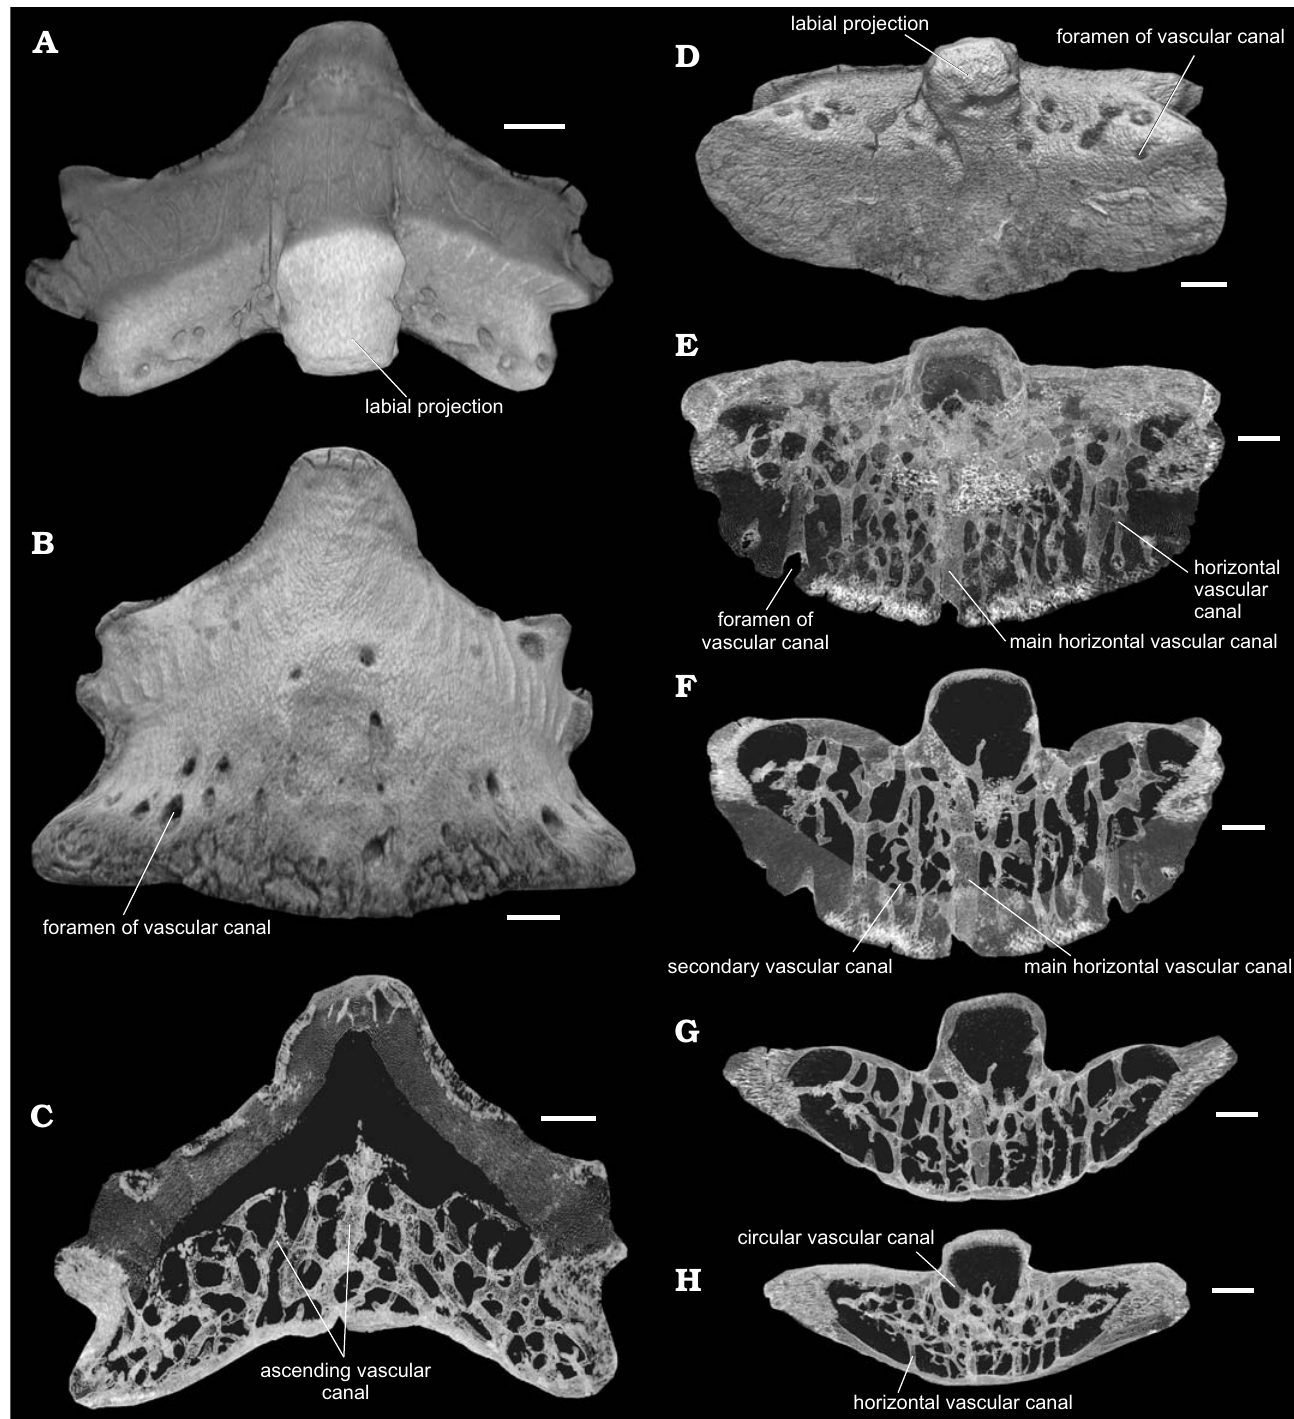
Fig. 5. Tooth (PM SPU 81-2) of the euselachian shark Artiodus prominens Ivanov and Duffin gen. et sp. nov. from the Artinskian (Early Permian) of Krasnoufimskie Klyuchiki quarry (Middle Urals, Russia). Micro-CT virtual model in labial ( A ), lingual ( B ), and basal ( D ) views. Virtual sections: longitudi- nal section of the tooth ( C ); section series of the base ( F – H ). Virtual model of the tooth in basal view with transparent dental tissues ( E ). Scale bars 500 μ